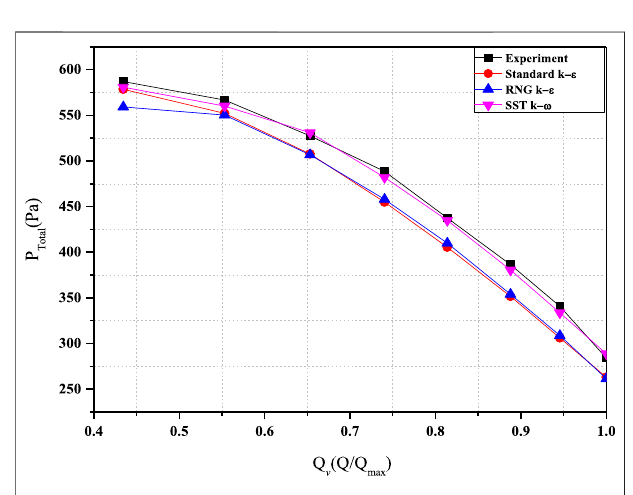
FIGURE 5 | Comparison of numerical calculation and experimental